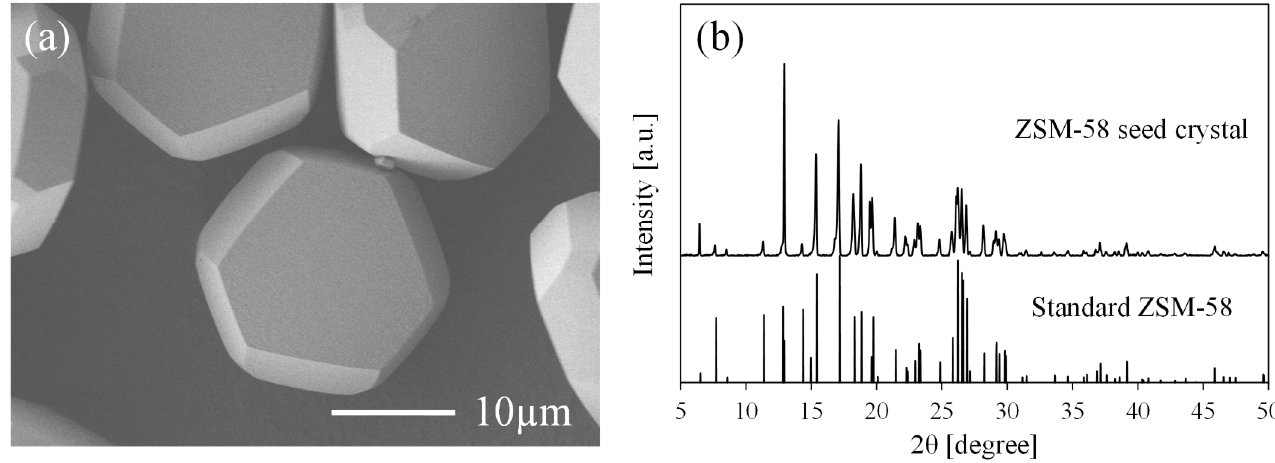
Figure 1. ( a ) SEM image and ( b ) XRD profile of ZSM-58 seed crystals used in this study.